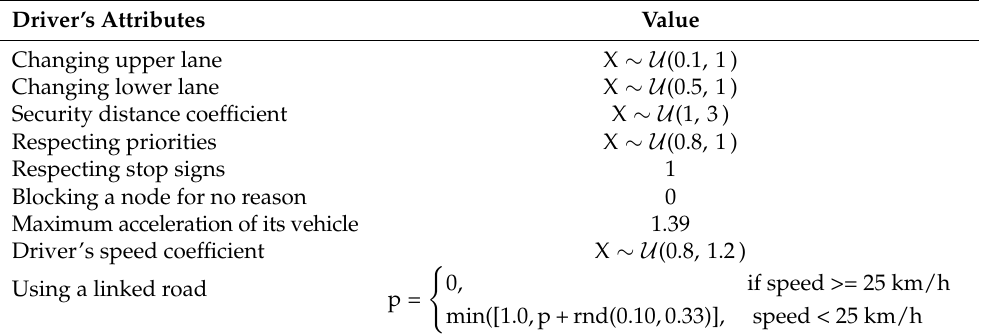
Table 2. Drivers’ behavioral